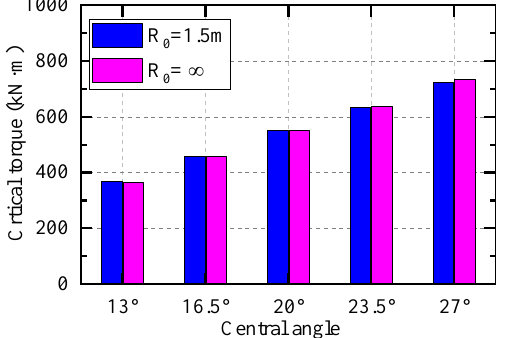
Figure 11. The critical torque under different R 2 or R 0 .